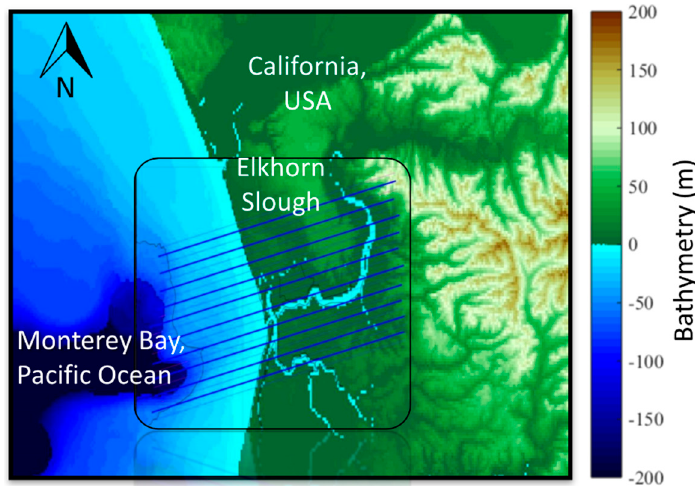
Figure 1. Elkhorn Slough, located along the California coastline at the head of Monterey Bay, is shown with gridded topography and the airborne tracks of PRISM imagery aligned in the plane of the sun to avoid cross-track illumination.